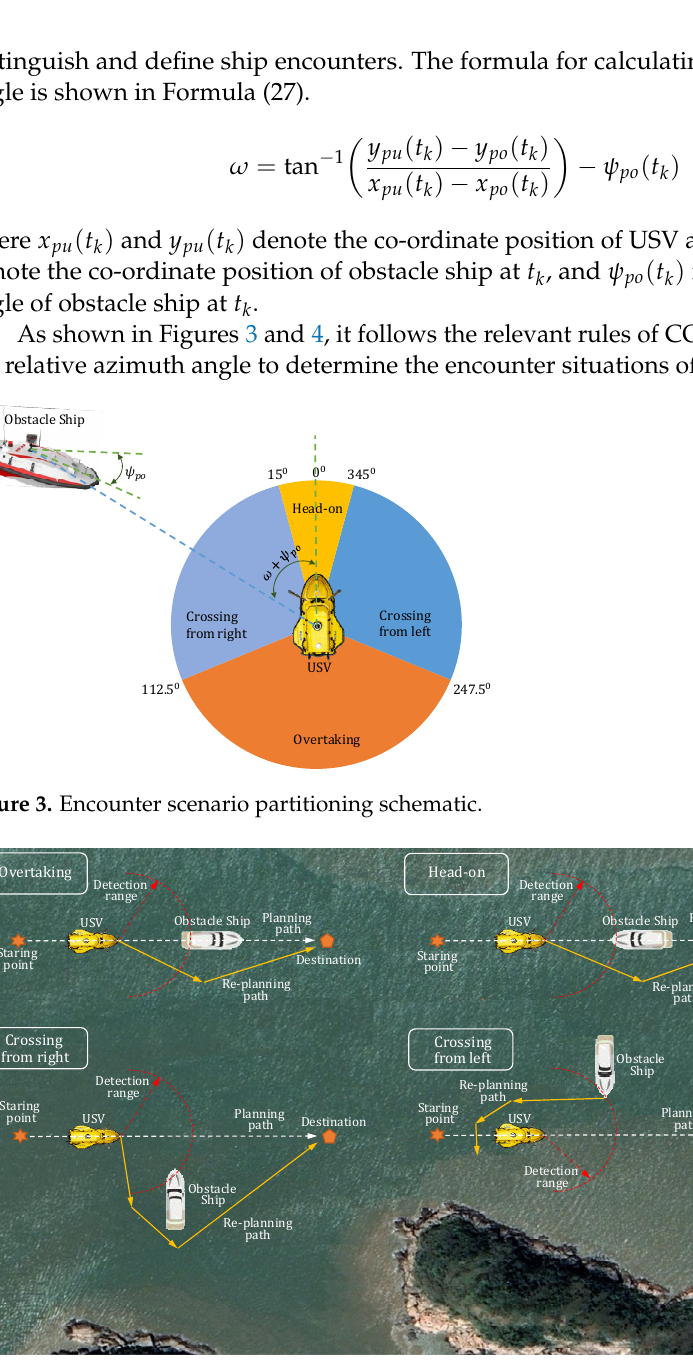
Figure 4. Obstacle avoidance diagram based on COLREGs.